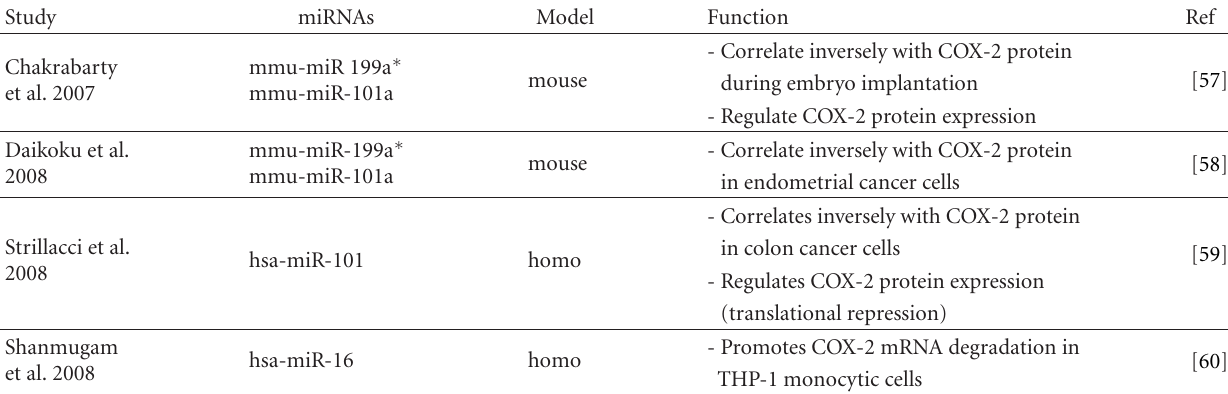
Table 2: Anti-COX-2